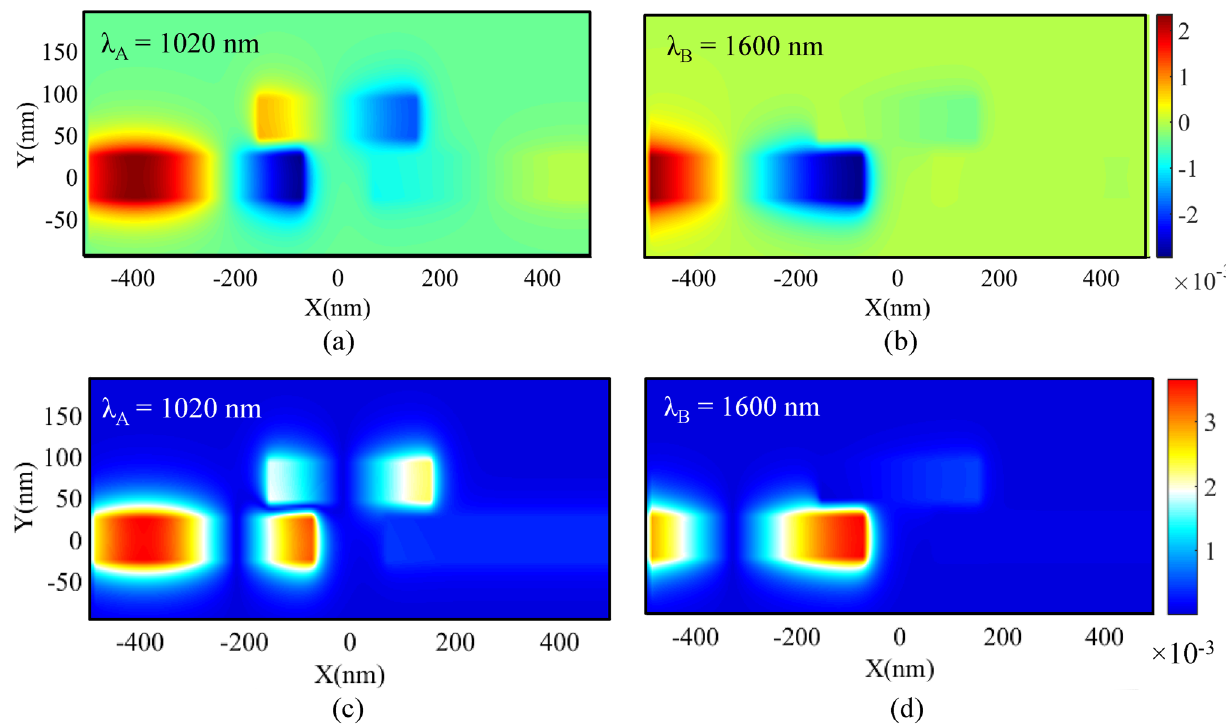
Figure 2. Field profile of Re (Hz) at (a) resonance wavelength. (b) Non-resonance wavelength. Field profile of | H z | at (c) resonance wavelength. (d) Non-resonance